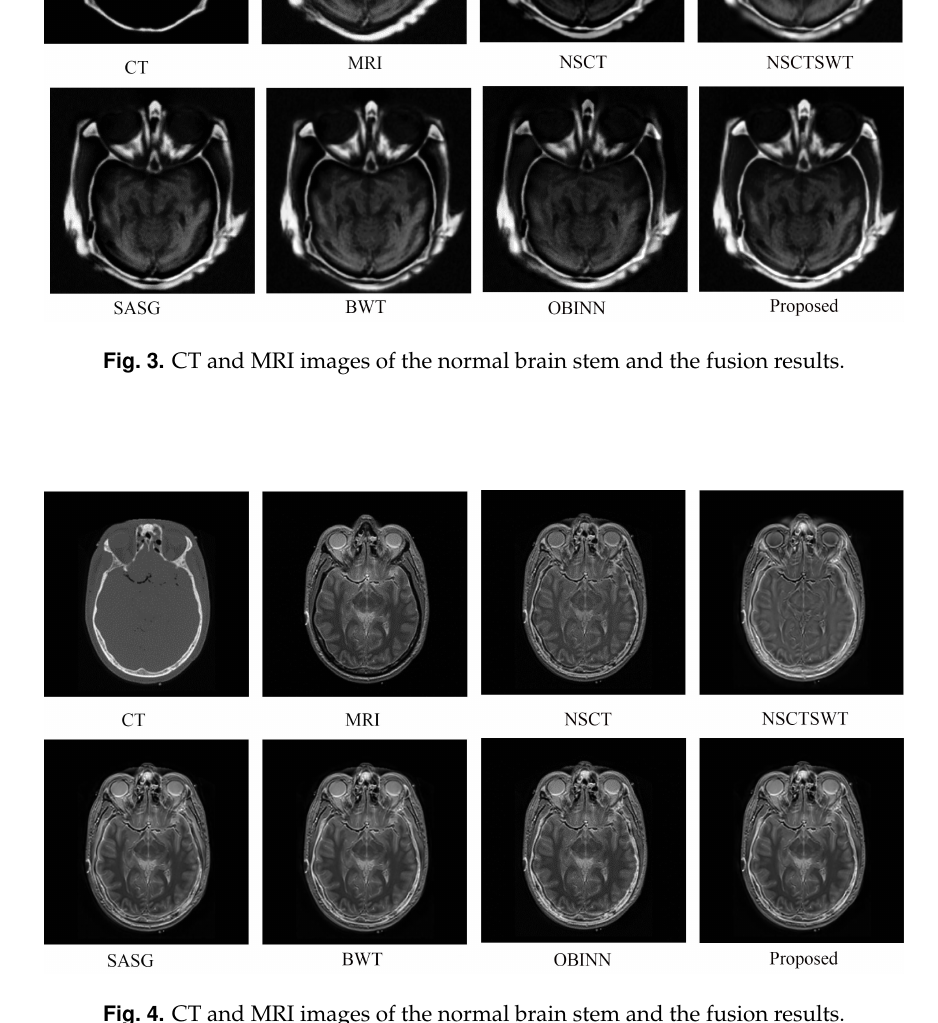
Fig. 4. CT and MRI images of the normal brain stem and the fusion results.